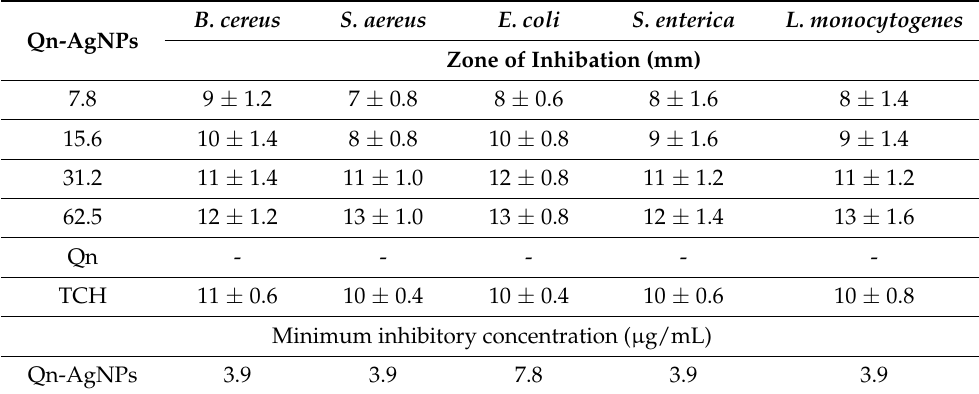
Table 1. Antibacterial activity. Zone of inhibition and MIC 50 of Qn-AgNPs, against bacterial pathogens. The zone of inhibition was compared with Qn and TCH. Qn- Quercetin; TCH-tetracycline hydrochloride.